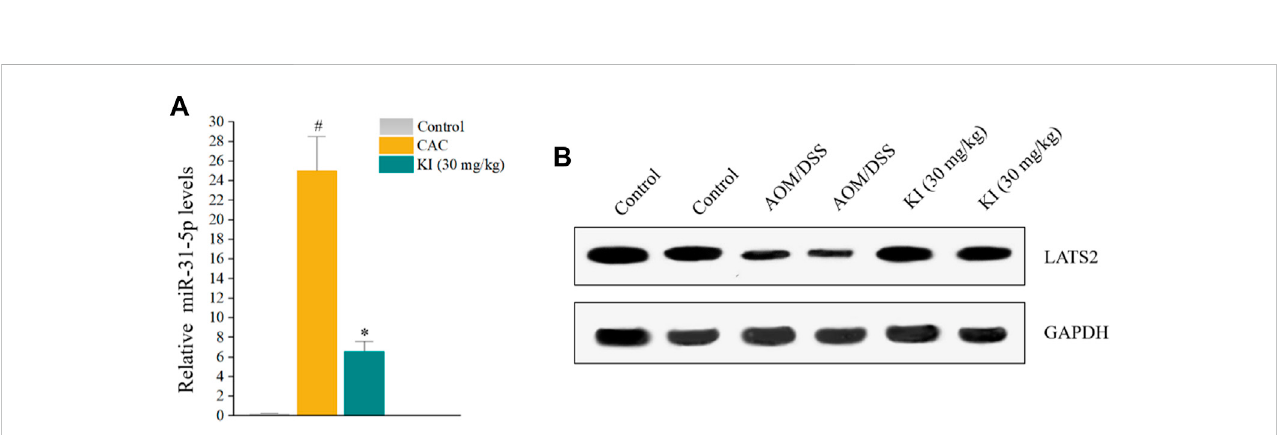
FIGURE 5 Effects of KI on miR-31-5p expression in CAC mice. (A) Rt-qPCR results of miR-31-5p in colon tissue at 10th week. Values are means ± SD from three separate experiments. # p < 0.05 compared with the control group; * p < 0.05 compared with AOM/DSS group. (B) Representative immunoblots of